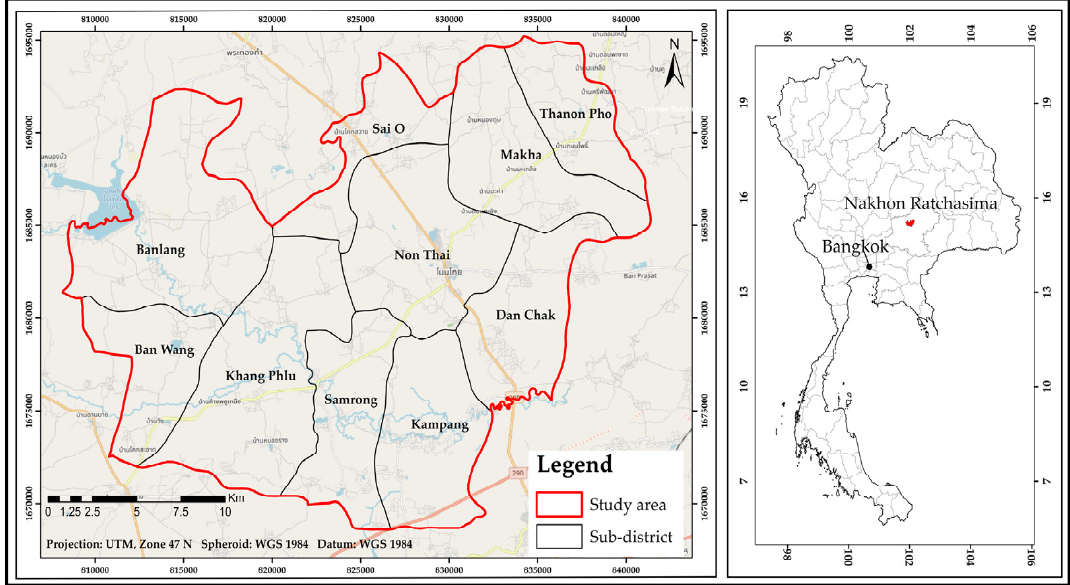
Figure 2. Location map of the study area.